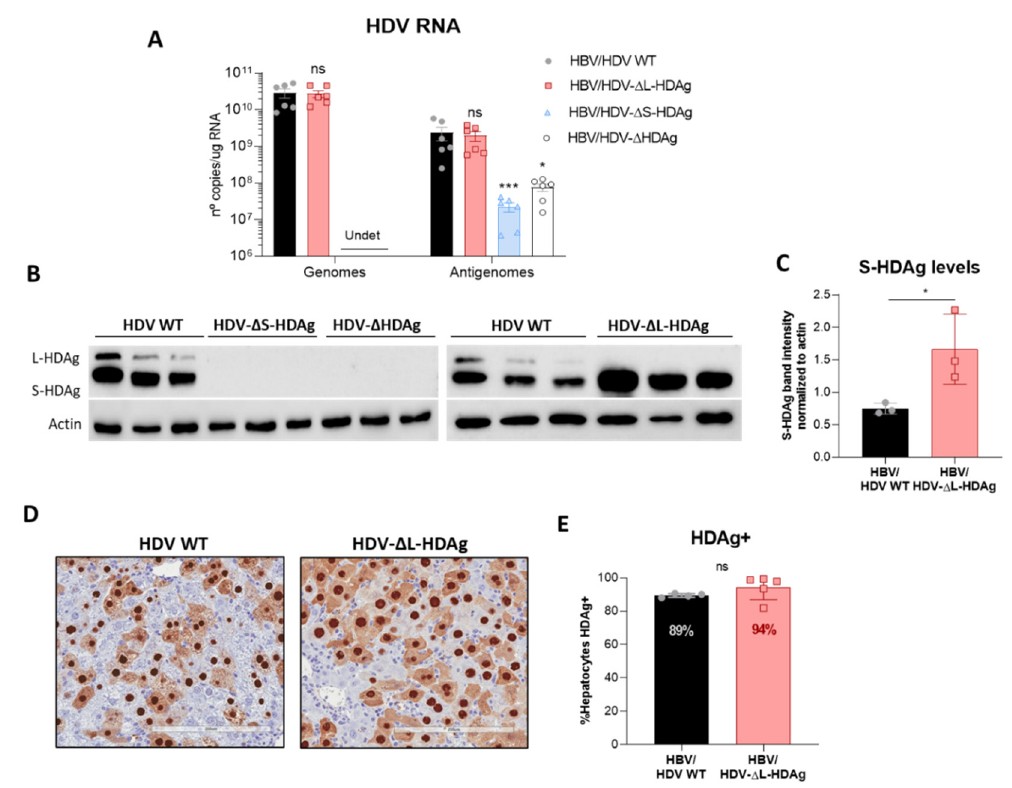
Figure 3. Administration of AAV-HDV mutants lacking the expression of S-HDAg resulted in a loss of HDV replication, while the absence of L-HDAg enhances S-HDAg production. Eight-week-old C57BL/6 WT mice received ( n = 6 mice/group) 5 × 10 10 genome copies of AAV-HDV, AAV-HDV- Δ L-HDAg, AAV-HDV- Δ S-HDAg and AAV-HDV- Δ HDAg in combination with 5 × 10 10 genome copies of AAV-HBV. ( A ) HDV genomes and antigenomes were analyzed in the livers of infected mice at 21 dpi (significant differences were determined by Kruskal-Wallis test and Dunn’s post-test). ( Undet : undetectable; ns: no significant, * p < 0.05, *** p < 0.001). ( B ) Western blot analysis of liver samples revealed the absence of HDAgs in mice receiving AAV-HDV- Δ S-HDAg and AAV-HDV- Δ HDAg, and only S-HDAg was detected in the livers of mice receiving the HDV- Δ L-HDAg vector. ( C ) The levels of S-HDAg were compared between the HDV WT and HDV- Δ L-HDAg groups by densitometry (* p < 0.05). ( D ) Immunostaining against HDAgs was performed at 21 dpi in the liver sections of mice injected with the AAV-HDV WT and AAV-HDV- Δ L-HDAg vectors. Scale bar: 200 µm. ( E ) HDAgs-posi- tive cells were quantified in both groups of mice ( n = 4–5). Mann–Whitney test revealed significant differences in S-HDAg protein levels and no differences between the percentage of HDAg-positive cells at 21 dpi (ns: no significant).